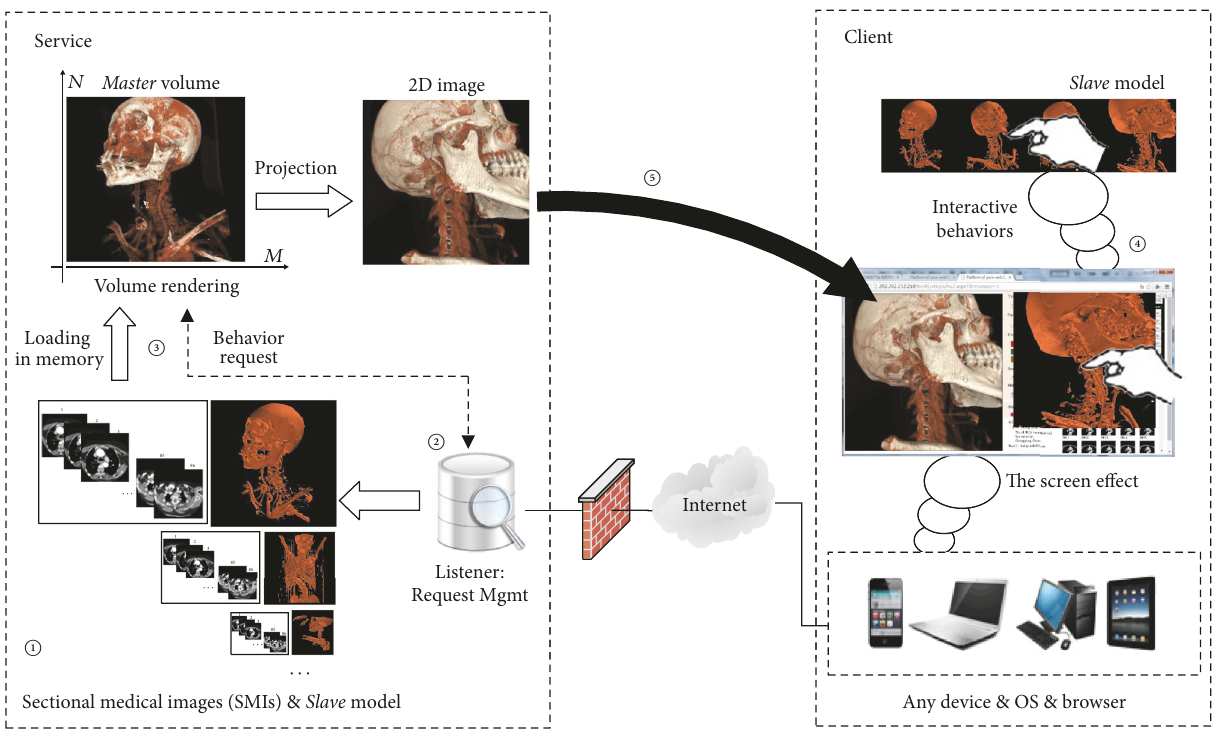
Figure 1: Architecture of the pure web-based solution via the Master-Slave dual-channel interaction